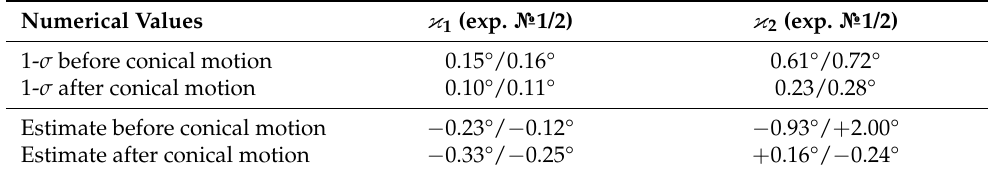
Table 4. Estimation results prior and after the conical